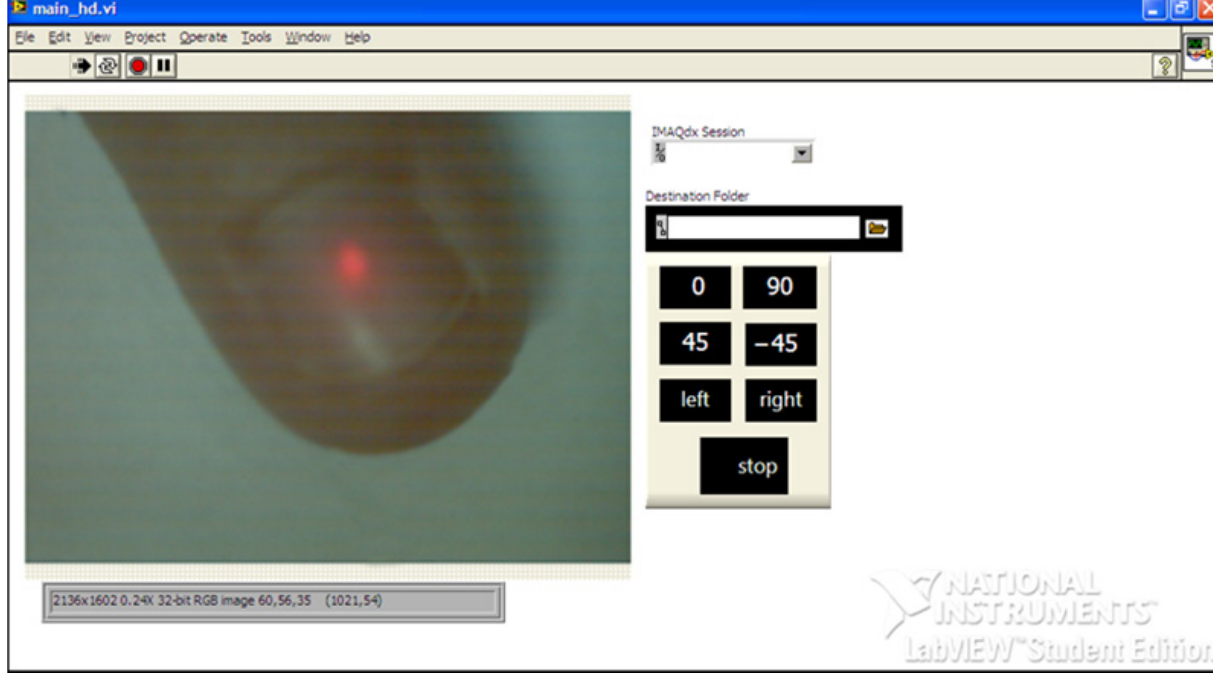
Figure 2. Software interface for recording the intensity distribution of angled scattered radiation on a matrix photodetector.